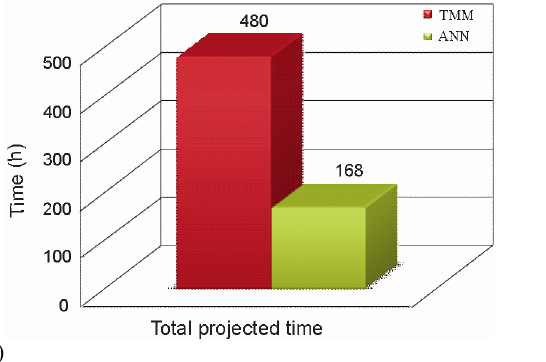
Fig. 8. Comparison of (a) total projected time and (b) computational